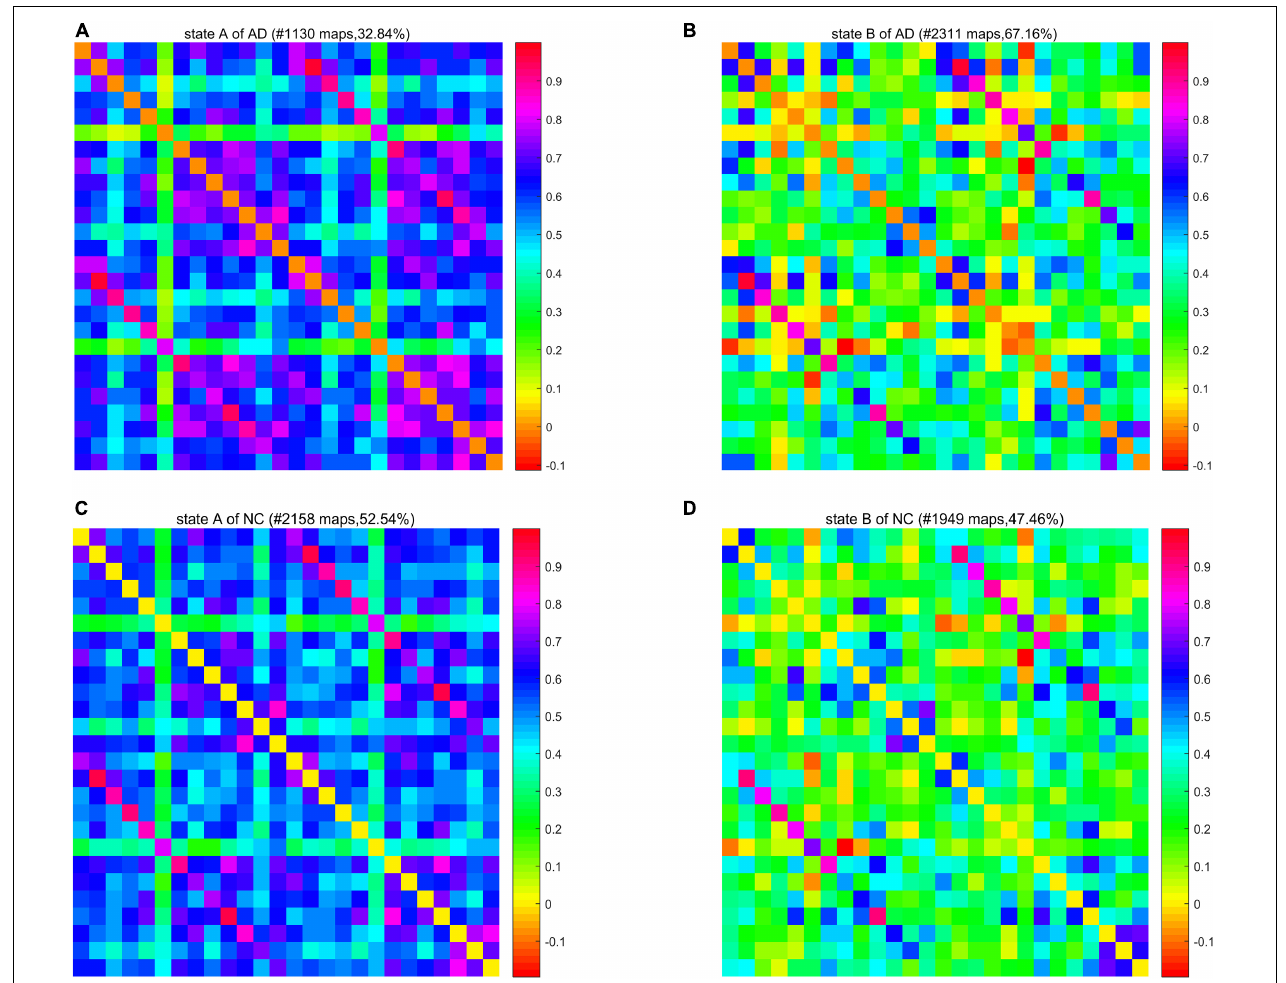
FIGURE 6 | The cluster center diagram of spatiotemporal default mode networks (DMNs) for AD and